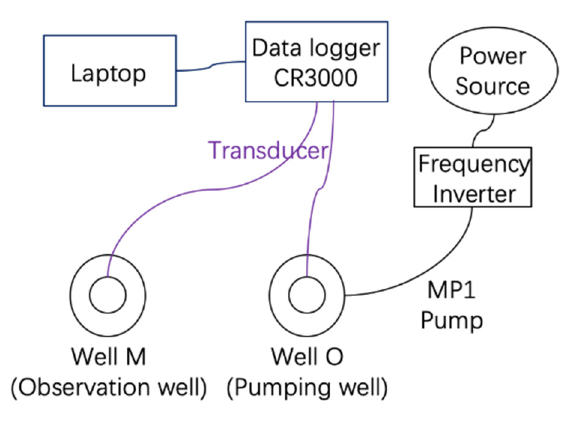
Figure 4. Experimental setup.